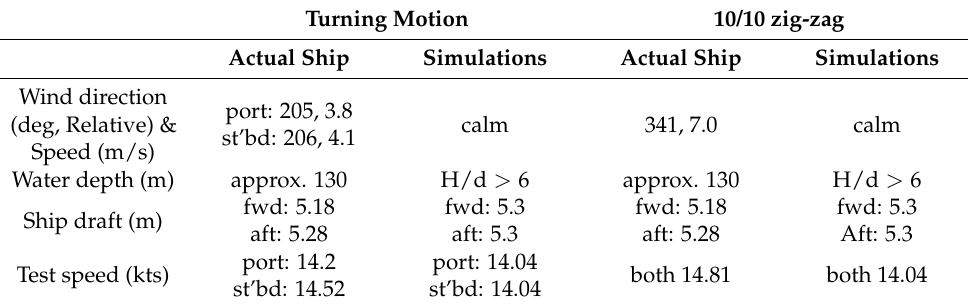
Table 6. Maneuverability evaluation conditions in deep